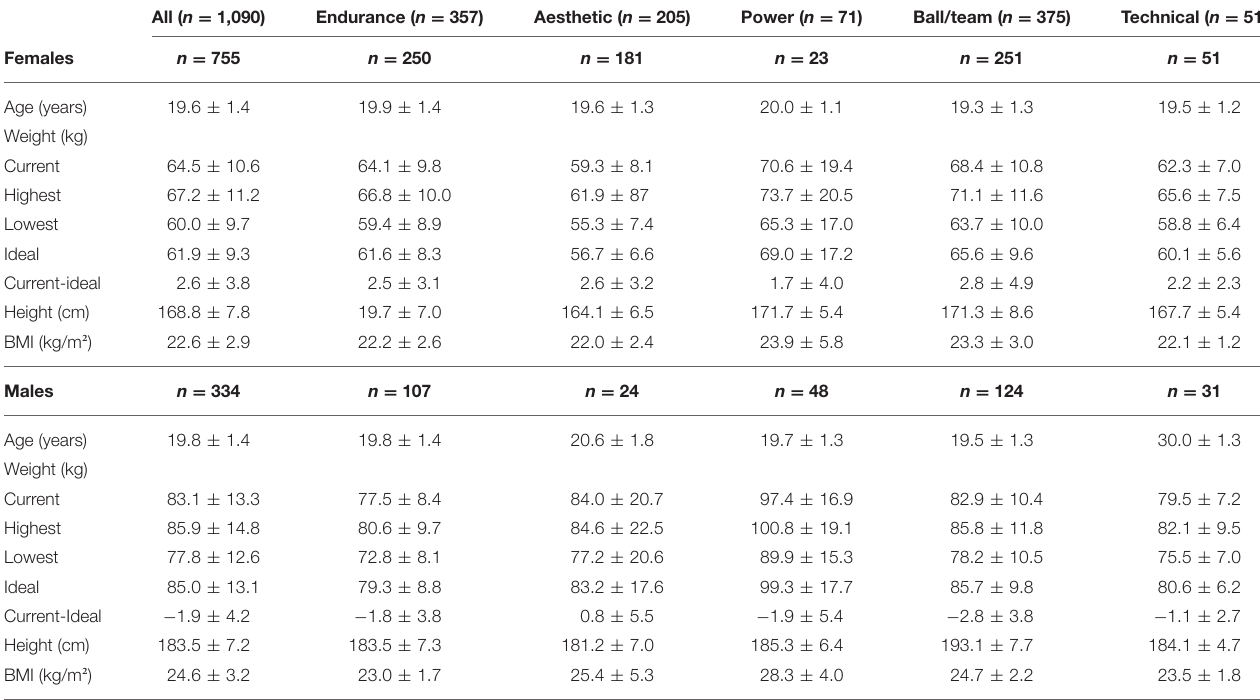
TABLE 1 | Descriptive statistics for participant demographics and self-reported anthropometrics. All ( n =